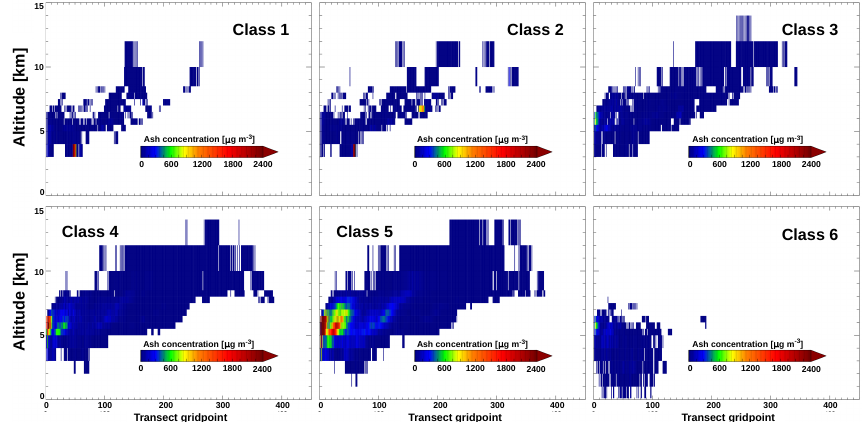
Figure 10. Ash vertical concentration profiles (in µgm − 3 ) for the six aerosol classes listed in Table 1, and identified in each panel, along the trajectory T of Figs. 5, 6, 7 and 9. Blue to red points indicate relatively low to high concentration